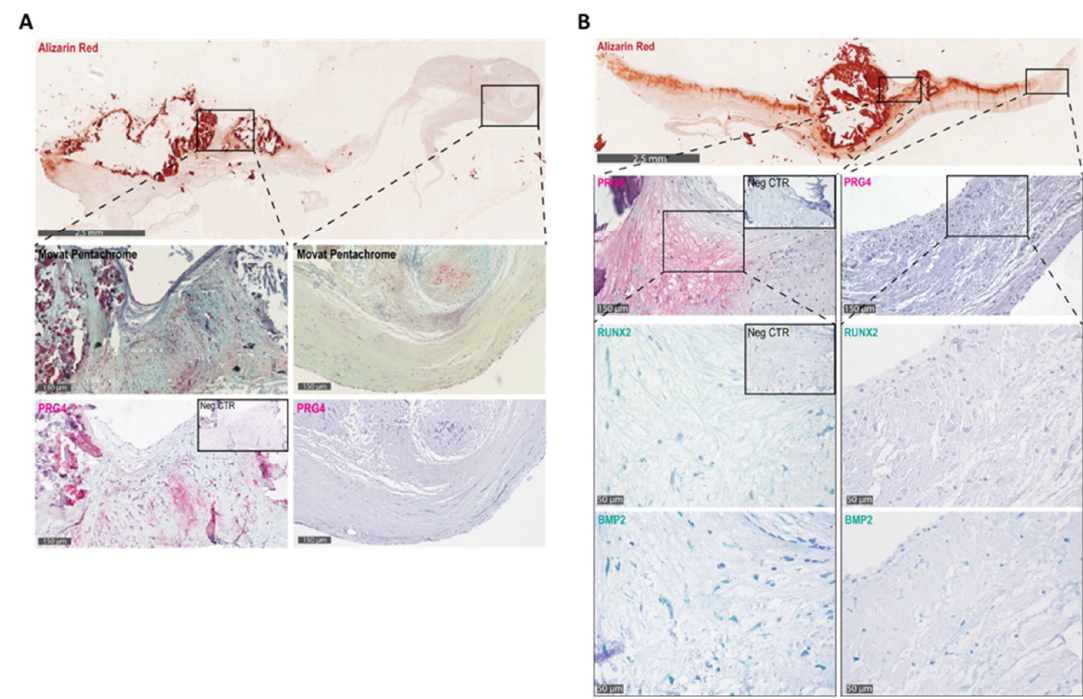
Figure 2. ( A ) Alizarin red staining (red, top panel), proteoglycans by Movat pentachrome (blue, middle panel), and proteoglycan-4 (PRG4) staining (bottom panel) in calcified and noncalcified regions of the aortic valve and ( B ) Alizarin red staining (red, top panel) and immunihistochemical stainings for PRG4, the runt-related transcription factor 2 (RUNX2), and bone morphogenetic protein 2 (BMP2) in calcified and noncalcified regions of the aortic valve.